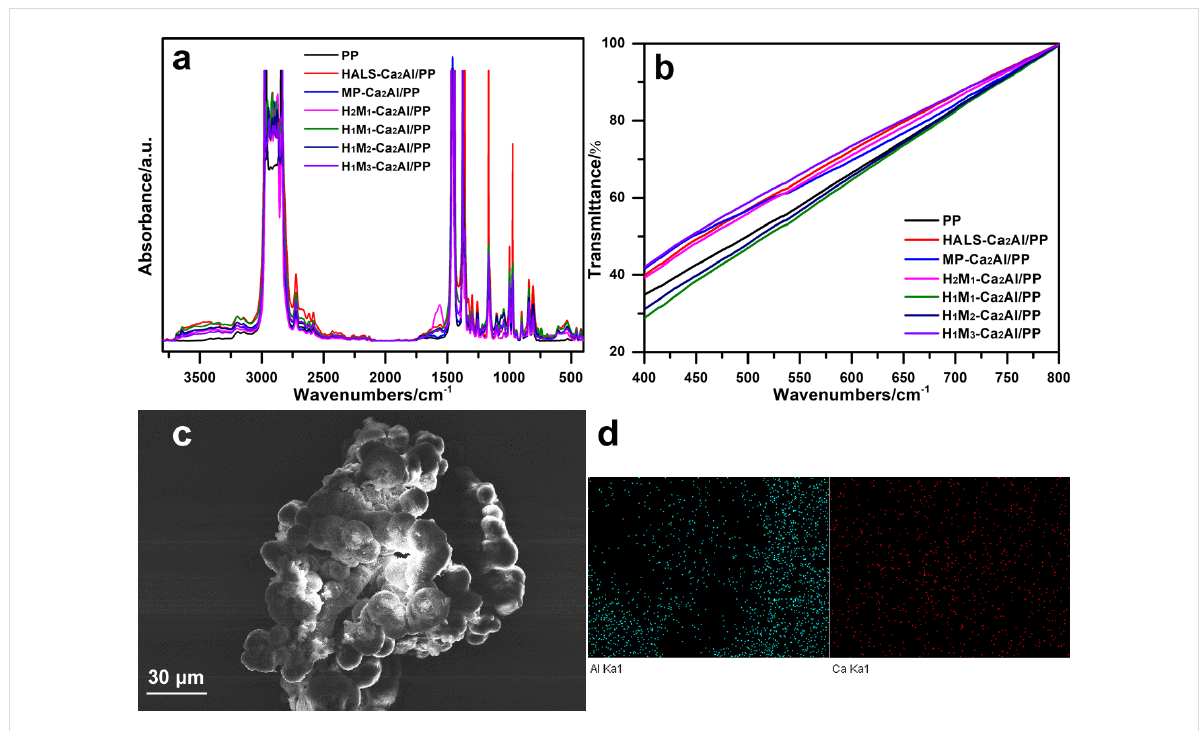
Figure 7: (a) FTIR spectra and (b) visible-light transmittance spectra of Ca 2 Al/PP composites. (c) SEM image and (d) Al (left) and Ca (right) element mapping of the H 1 M 1 -Ca 2 Al/PP composite.